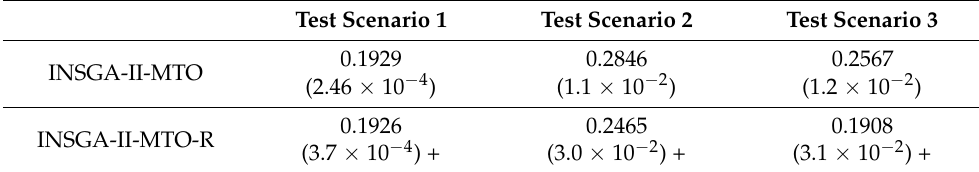
Table 3. HV results of the INSGA-II-MTO and INSGA-II-MTO-R.